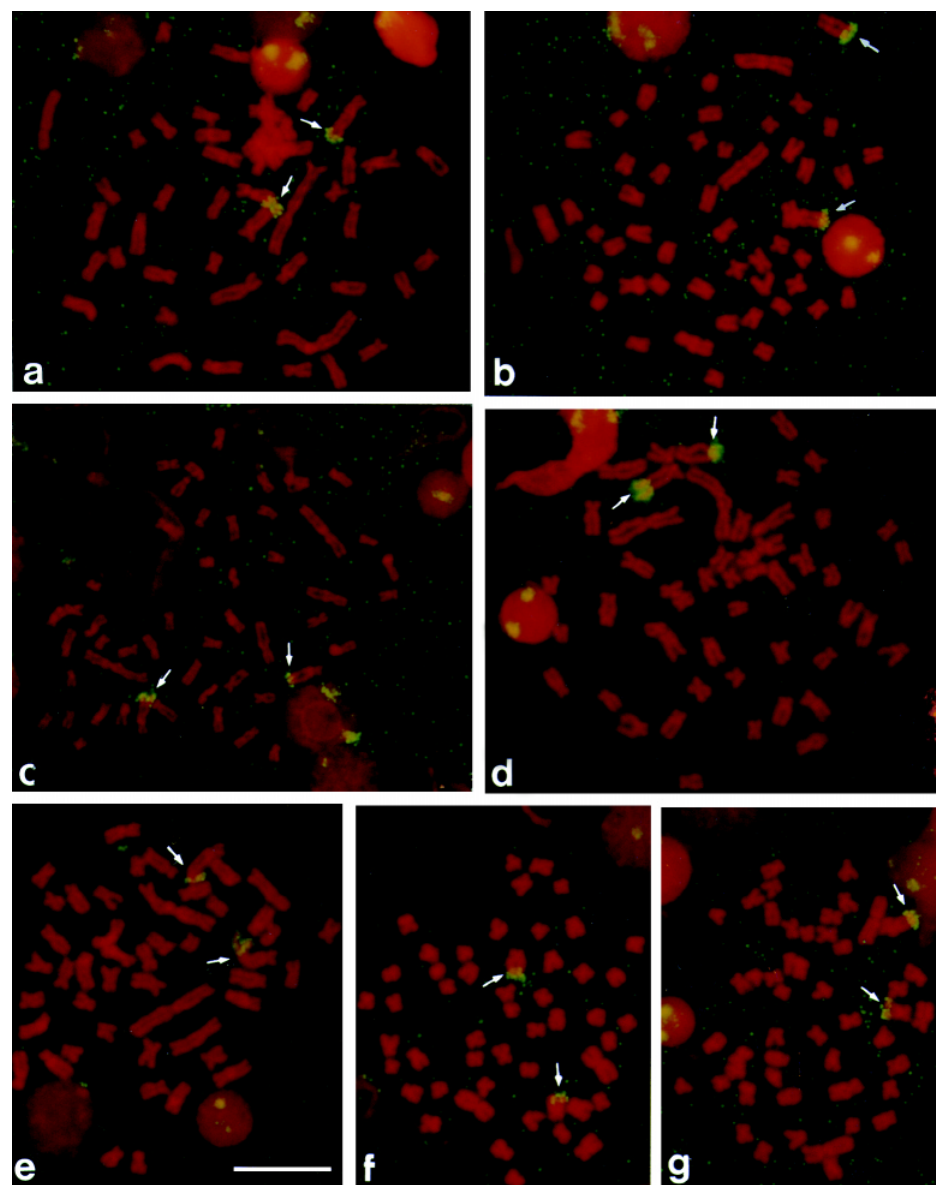
Figure 1 - 18S rDNA-FISH in Brycon . (a) B. brevicauda , (b) B. cephalus , (c) B. microlepis , (d) B. orbignyanus , (e) B. lundii , (f) Brycon sp., (g) B . insignis . Arrows indicate rDNA sites. Bar = 3 m